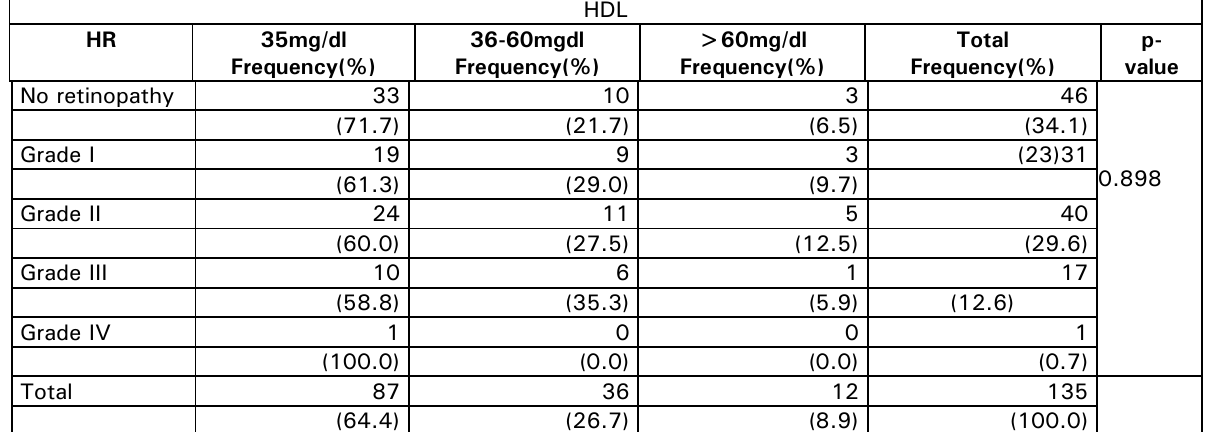
Table 9 Association with HDL